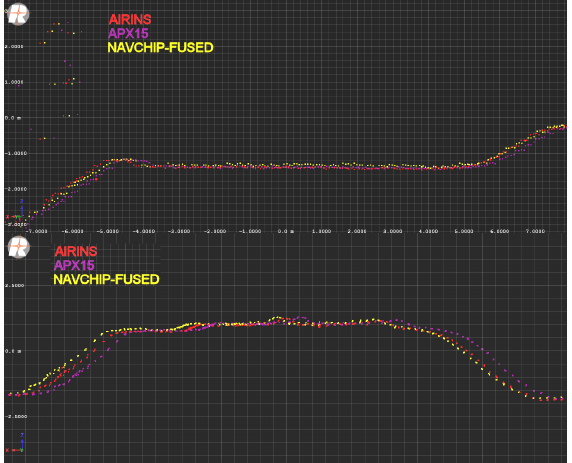
Figure 8: Cross section 1 (top) and 2 (bottom) at edge of swath. Red cloud is AIRINS reference. Planimetric difference is the main error, not detected on flat surface but manifesting immediately with slopes.